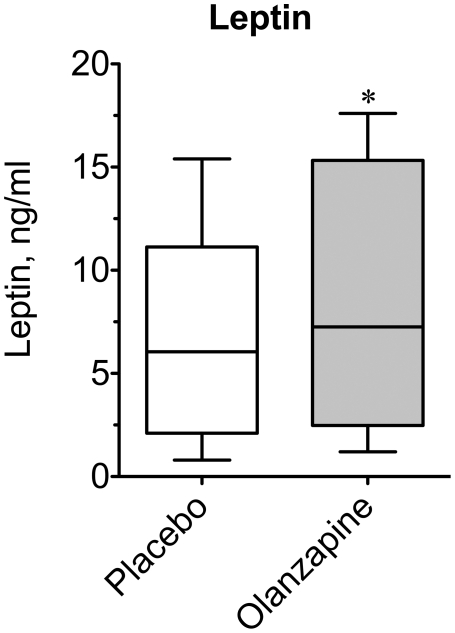
Effect of olanzapine on plasma leptin.Baseline fasting blood samples were drawn approximately 10–12 h following the final dose of olanzapine or placebo tablets. Plasma leptin was measured at the conclusion of the study for each subject under placebo- and olanzapine-treated conditions. Data are expressed as a box plot for placebo and olanzapine-treated subjects. An asterisk indicates (P = 0.02) a significant difference between the medians of the placebo and olanzapine groups using a Wilcoxon matched-pairs signed rank test (n = 15).